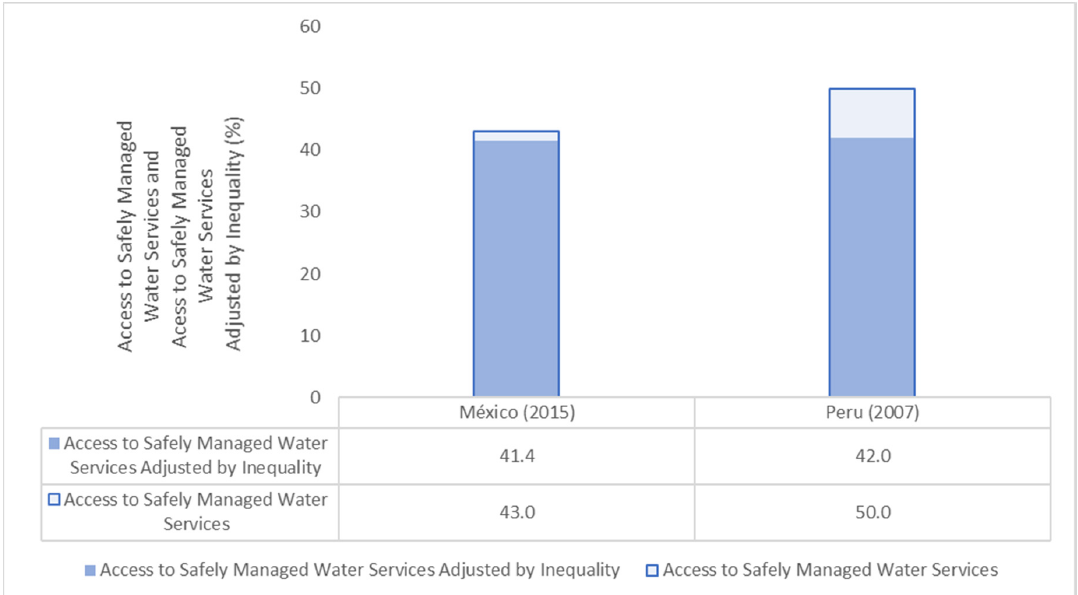
Figure 7. Mexico and Peru—access to safely managed water services and access to safely managed water services adjusted by inequality. Source: Own elaboration based on census microdata from the IPUMS-International Project [25].